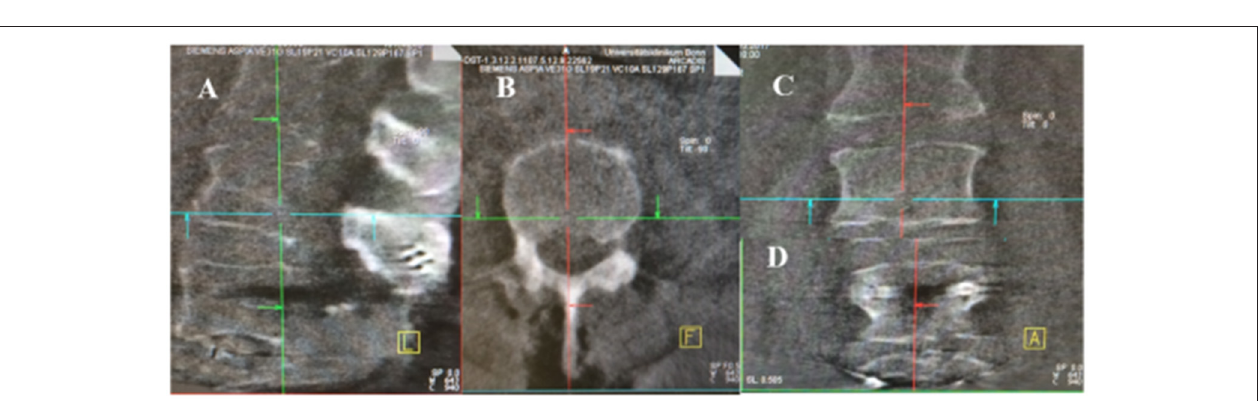
FIGURE 2 | Live Foto from the intraoperative room at our institution during the 3D rotation.